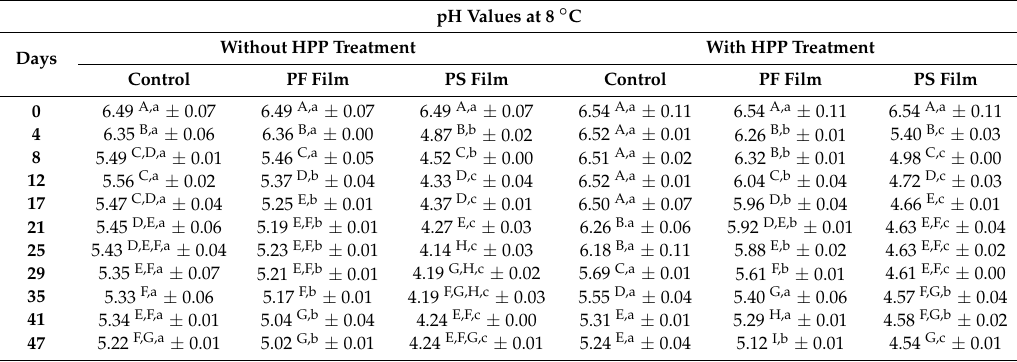
Table 2. Changes in pH values for ham slices treated or not with HPP, during storage at 8 ◦